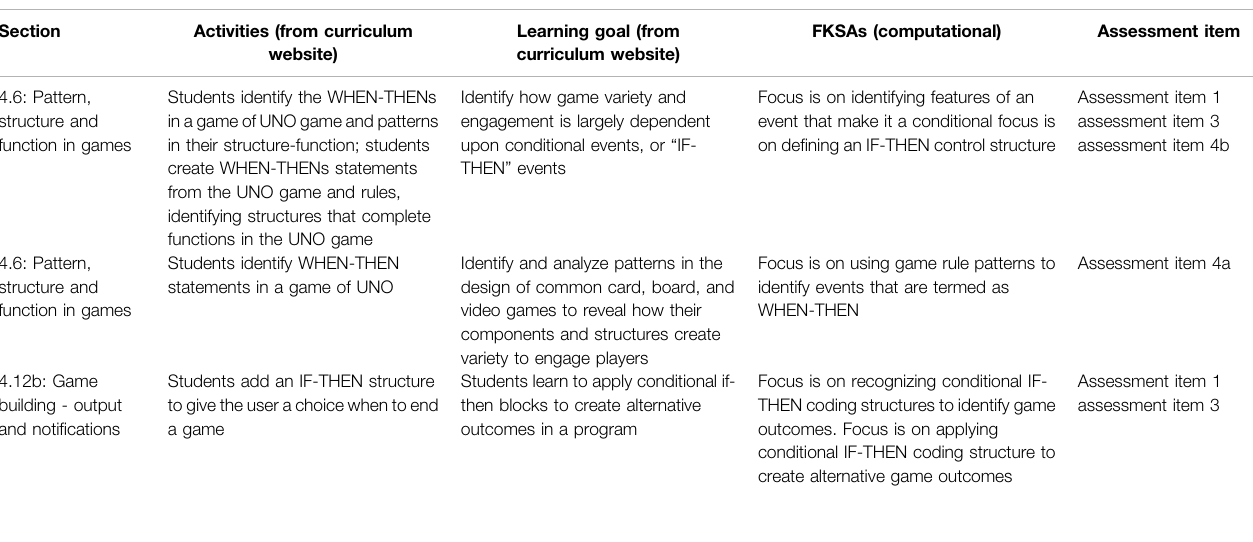
TABLE 6 | Design patterns rows corresponding to Unit 4 sample assessment